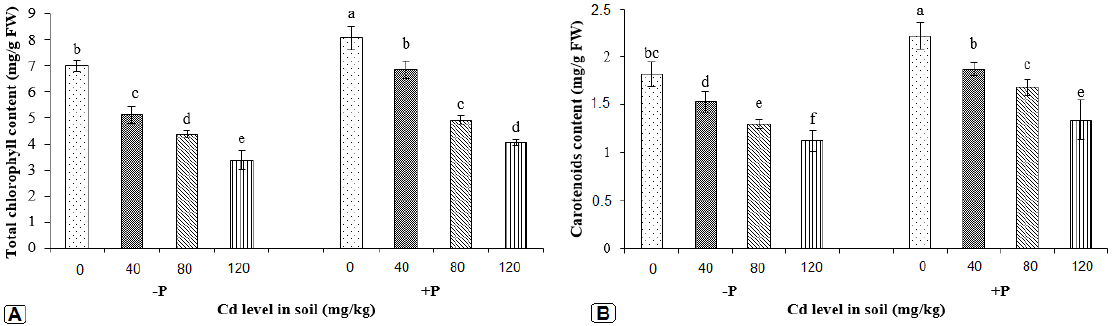
Fig. 3. The effect of P. indica on A) total chlorophyll and B) carotenoids contents in sunflower under different Cd concentrations in soil. P: P. indica. Values are mean ± SD; n = 5. The same letter within each column indicates no significant difference among treatments using Duncan’s Multiple Range Test at P <